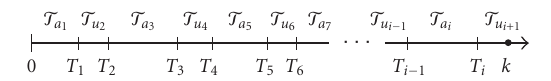
Figure 2: Operation time line with availability intervals alternating with unavailability